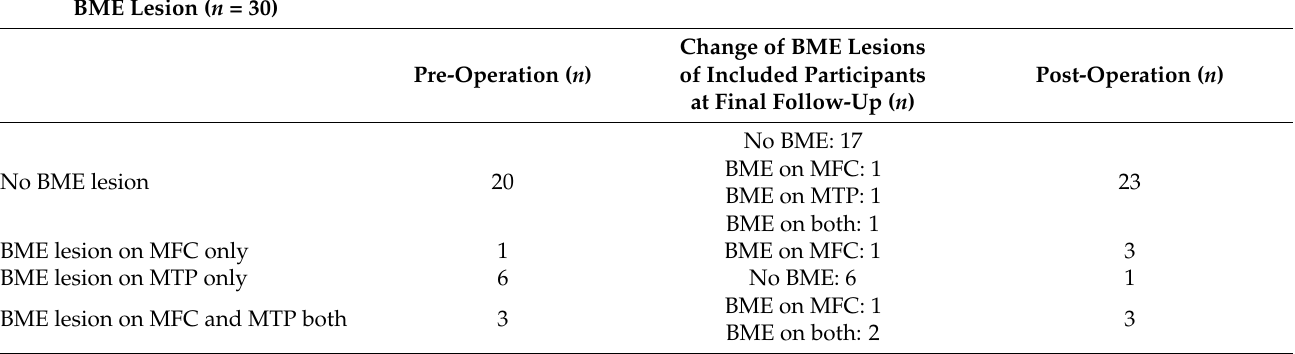
Table 2. Bone Marrow Lesions (BME) of Included Participants.